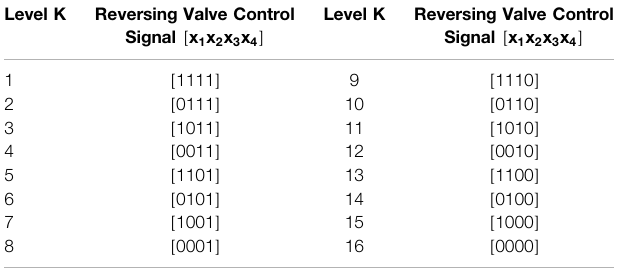
TABLE 1 | Adjustment level and control signal of directional valve.